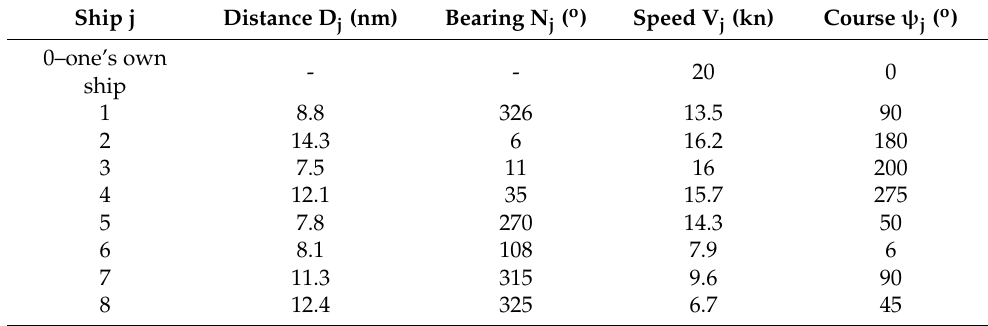
Table 2. Data describing the situation of one’s own ship passing by eight encountered